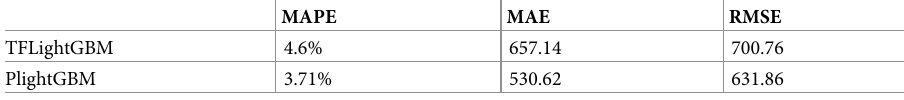
Table 3. Comparison of the results of P-feature and TF-feature in LightGBM.